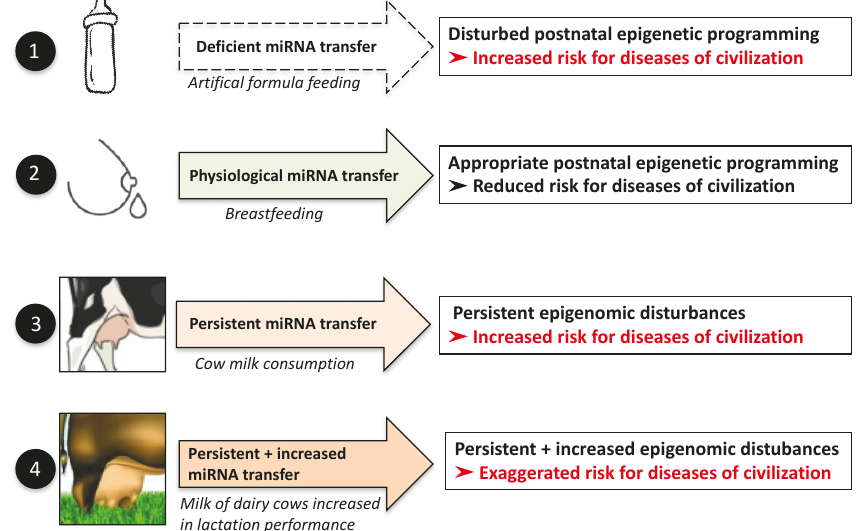
Figure 4. Comparison of milk-miRNA-mediated epigenetic signaling to the human milk